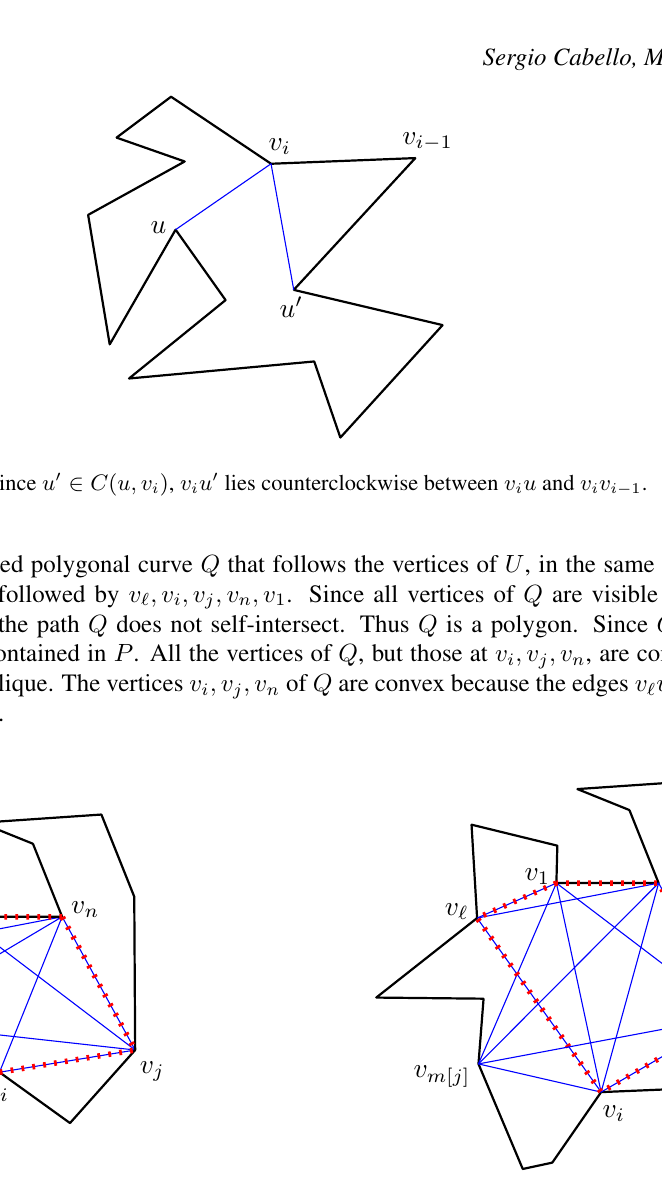
Figure 3: Illustrations for Lemmas 2 (left) and 3 (right). Solid edges belong to the visibility graph by hypothesis. Left: U = { v q } and the dotted polygonal curve shows Q . Right: The dotted polygonal curve shows Q (cid:96) . Since Q m [ j ] is convex, so is Q (cid:96)